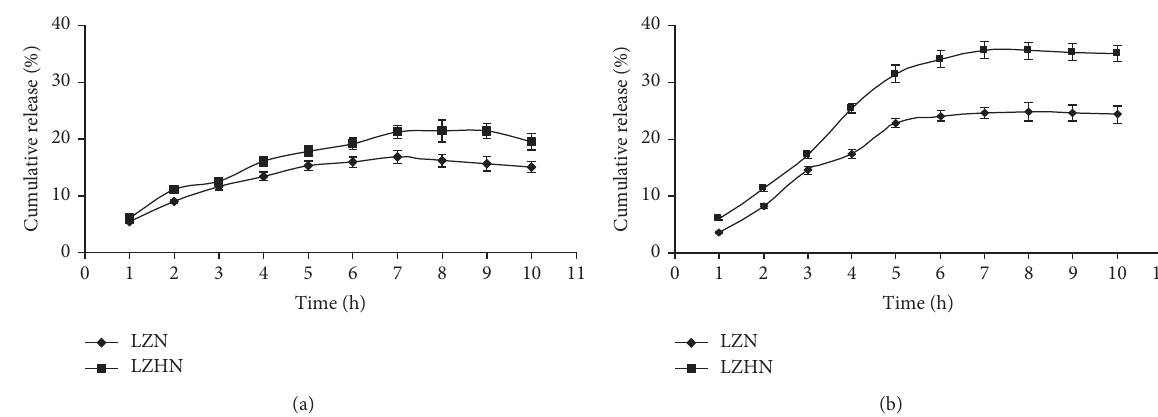
Figure 7: Lutein cumulative release of LZN and LZHN during digestion in SGF (a) and in SIF (b) for